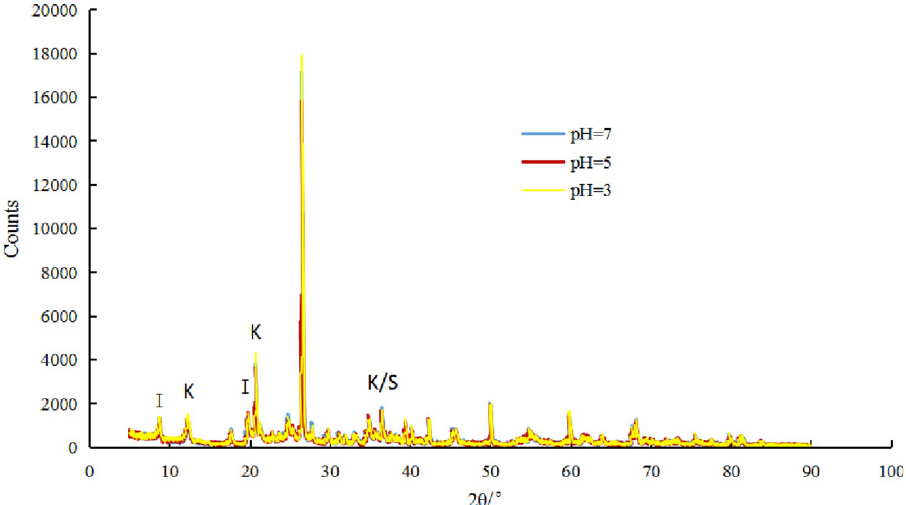
Fig 3. Comparison of XRD patterns of samples under acidic conditions; I is the illite, K is the kaolinite, and S is the quartz.